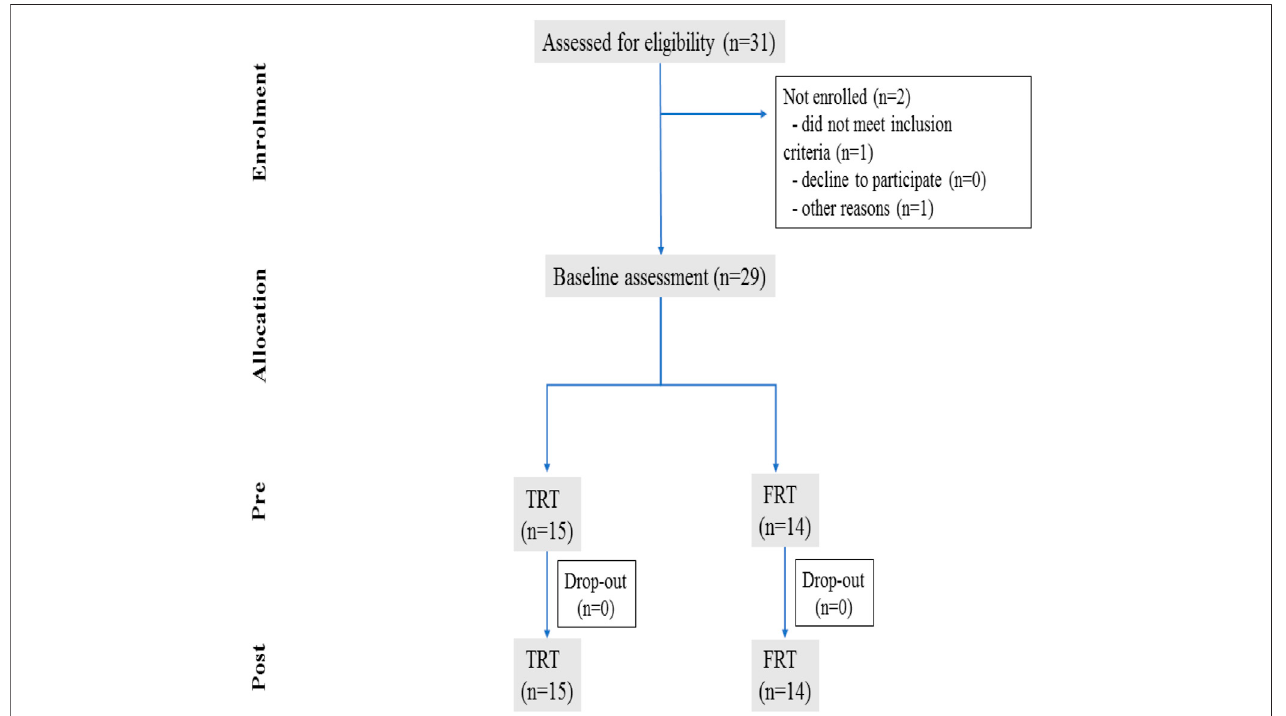
FIGURE 1 | Flow diagram of participants ’ training schedule through the study.